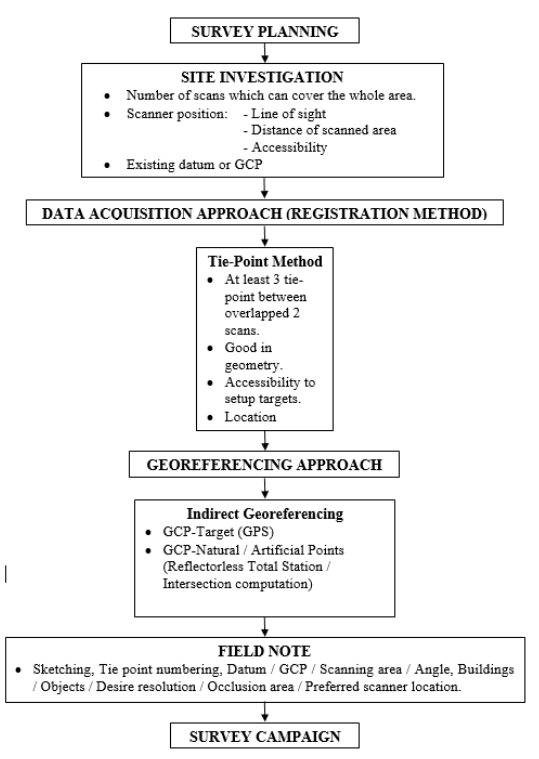
Figure 7. Field survey strategy